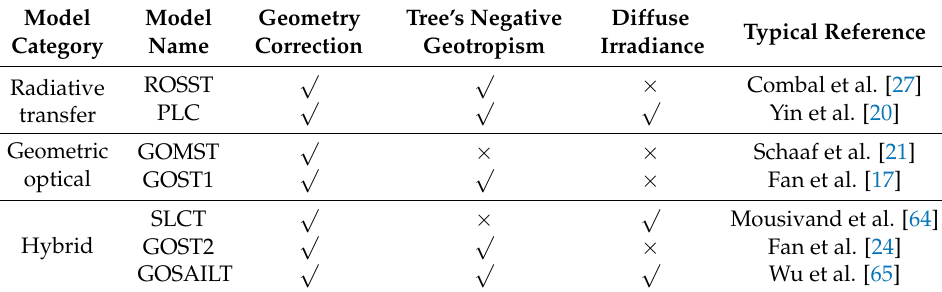
Table 1. List of physical solo slope surface BRDF